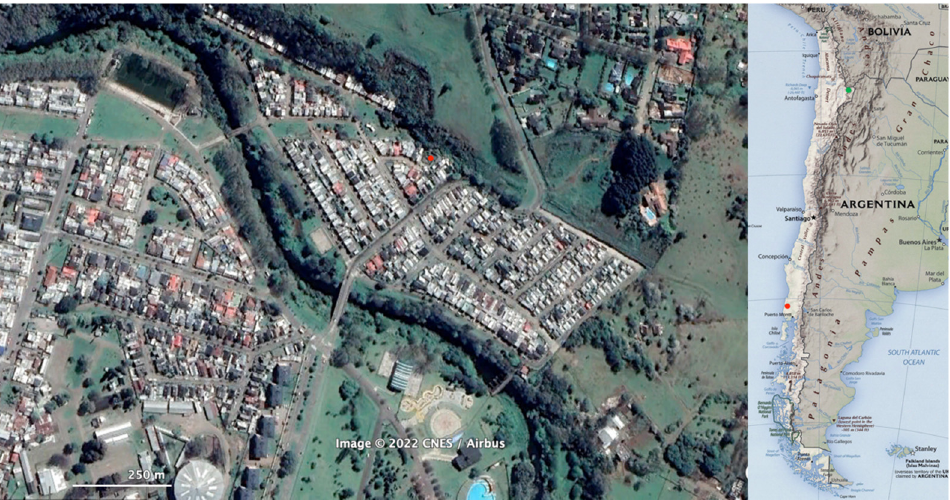
Figure 1. Location map of Pilauco site (red dot) in Osorno City. A green dot indicates the source of the obsidian in the north of Chile. Image obtained from Google Earth.